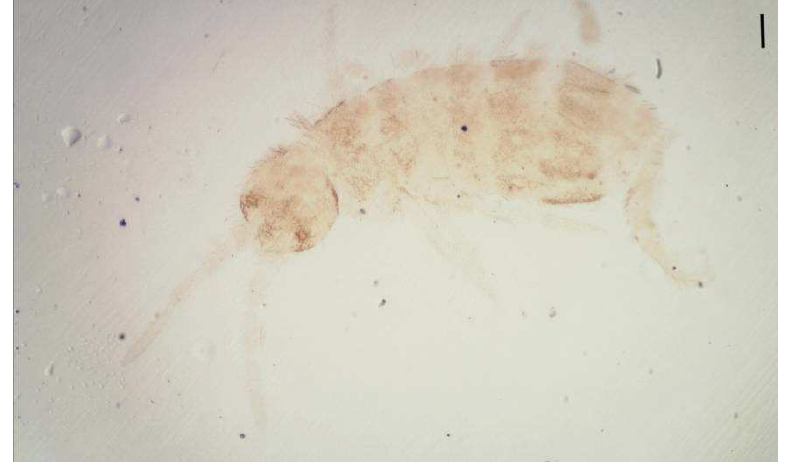
F IGURE 6 . Reddish pigment and 1+1 ocelli in H. nitidus (scale: 1000 µm) .